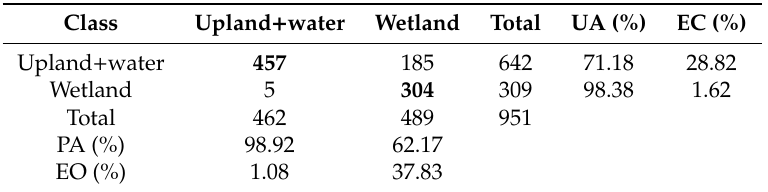
Table 12. Confusion matrix (in the number of sites) and associated accuracies when comparing the 2019 NB reference map to the 951 in-situ GPS field sites(*)